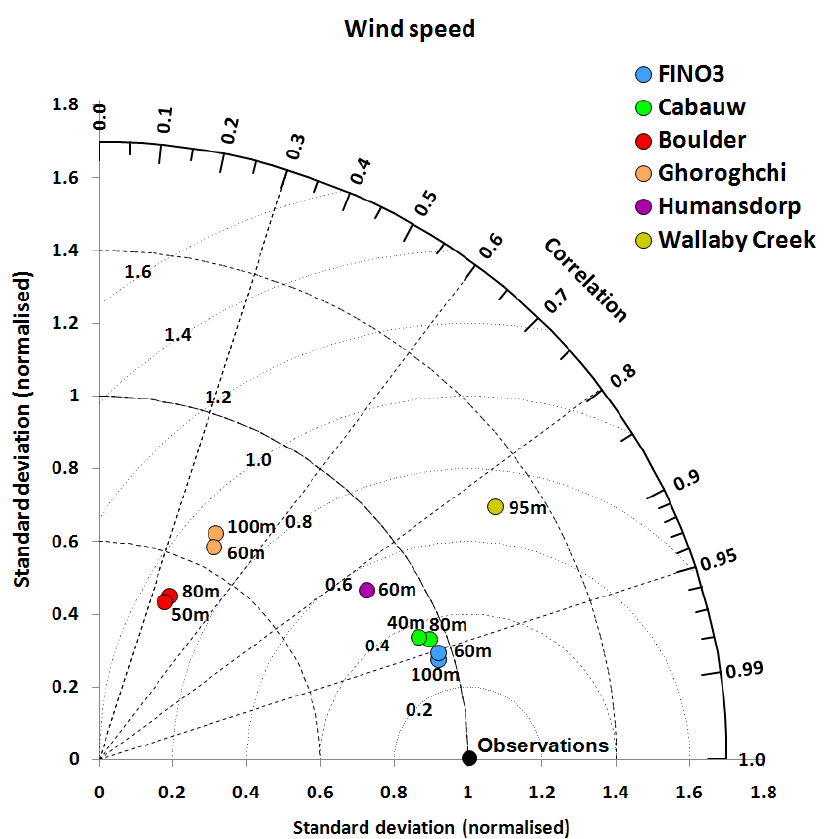
Figure 2. Taylor diagram of annual mean wind speed predicted by height by ERA5 reanalysis data at the six tower locations. Standard deviations of predictions ( σ P ) and RMSD (proportional to the radial distance from observations) are normalised by the standard deviation of observations ( σ O